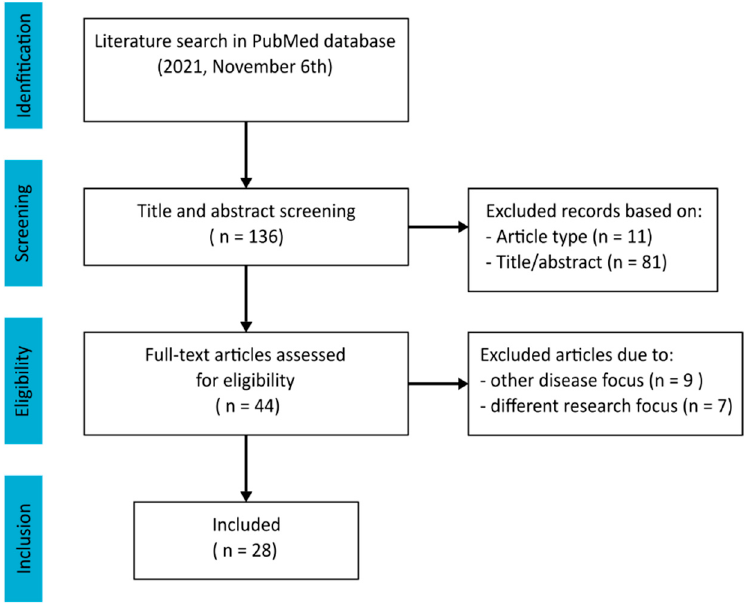
Figure 1. Flow diagram of article selection.